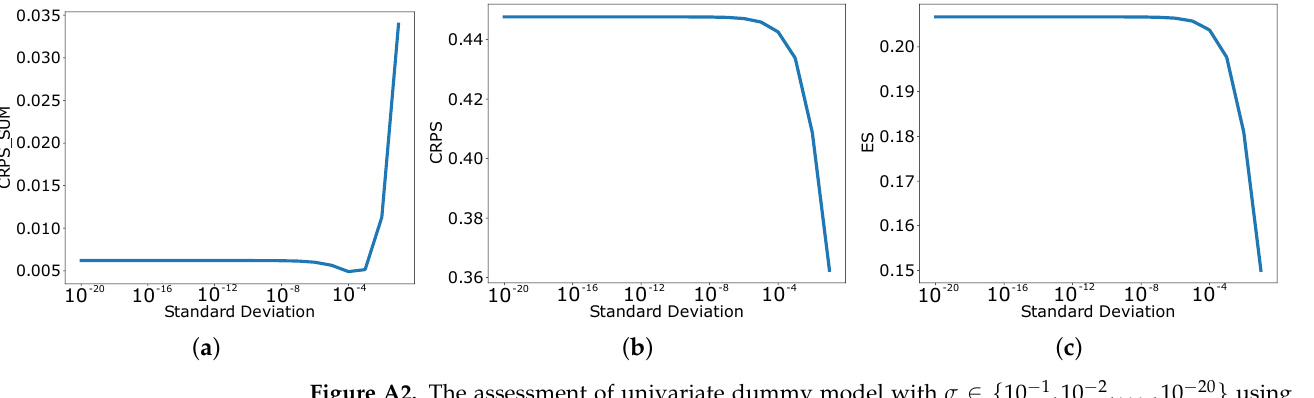
Figure A2. The assessment of univariate dummy model with σ ∈ { 10 − 1 ,10 − 2 , . . . ,10 − 20 } using CRPS-Sum, CRPS and ES. The plot is depicted on logarithmic scale. ( a ) CRPS-Sum. ( b ) CRPS. ( c ) ES.